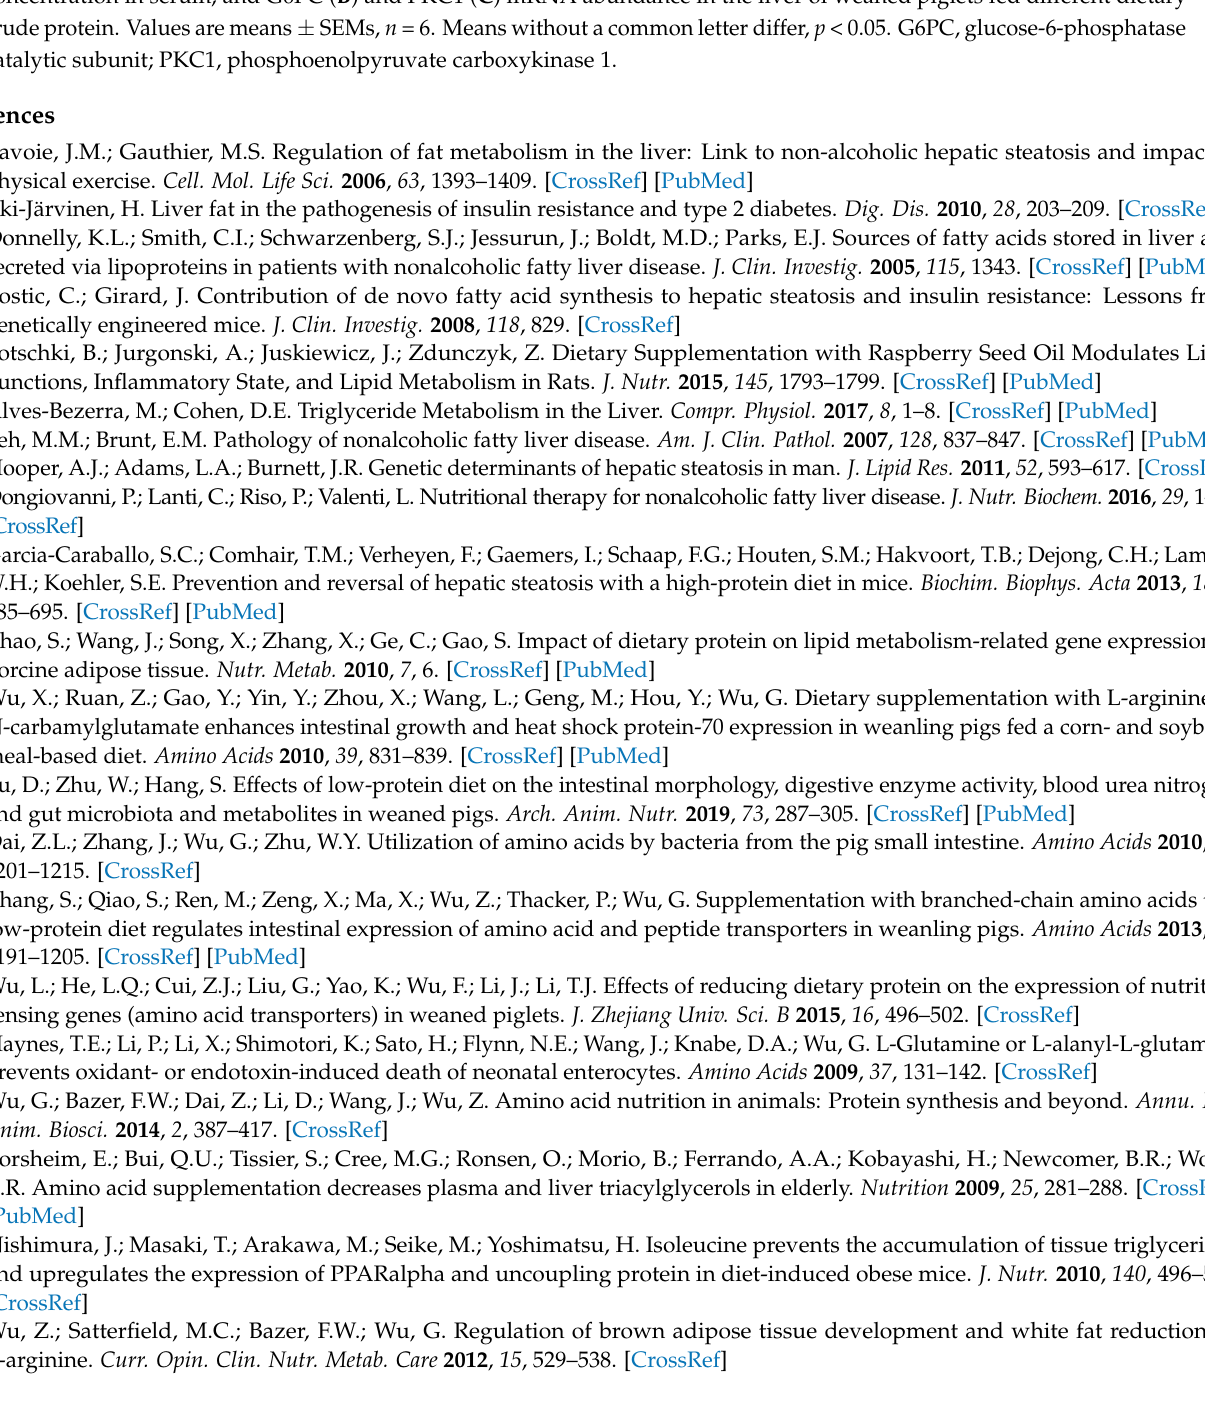
Figure A4. Effects of dietary crude protein level on serum urea concentrations and hepatic gluconeo-genesis. Urea ( A ) concentration in serum, and G6PC ( B ) and PKC1 ( C ) mRNA abundance in the liver of weaned piglets fed different dietary crude protein. Values are means ± SEMs, n = 6. Means without a common letter differ, p < 0.05. G6PC, glucose-6-phosphatase catalytic subunit; PKC1, phosphoenolpyruvate carboxykinase 1.